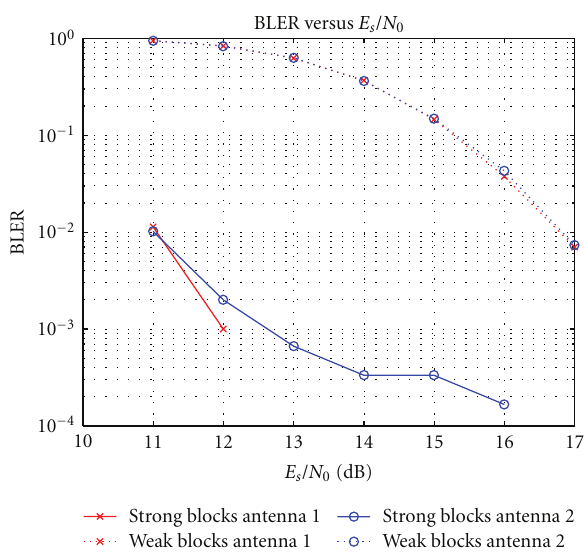
Figure 10: BLER performance of 2 × 2 MIMO 16QAM turbo-coded transmission with CRM2, TypU